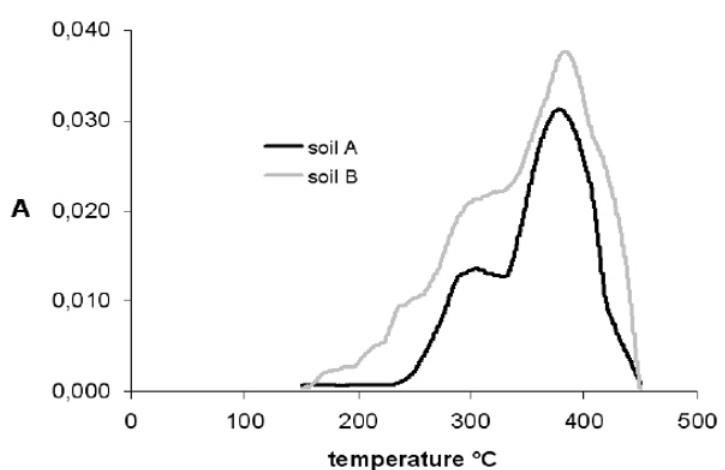
Figure 4. Mercury release curves of artificial soil A and